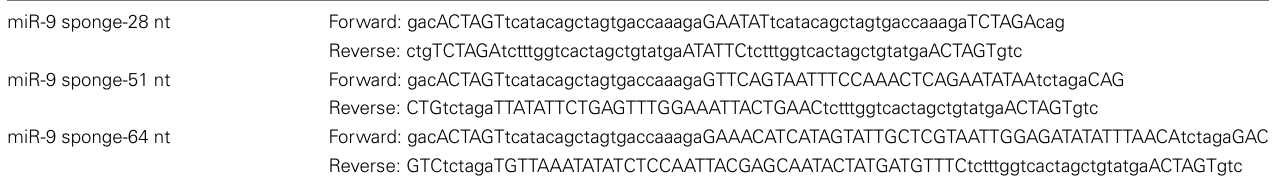
Table 1 | Sequences of oligos used to create miR-9